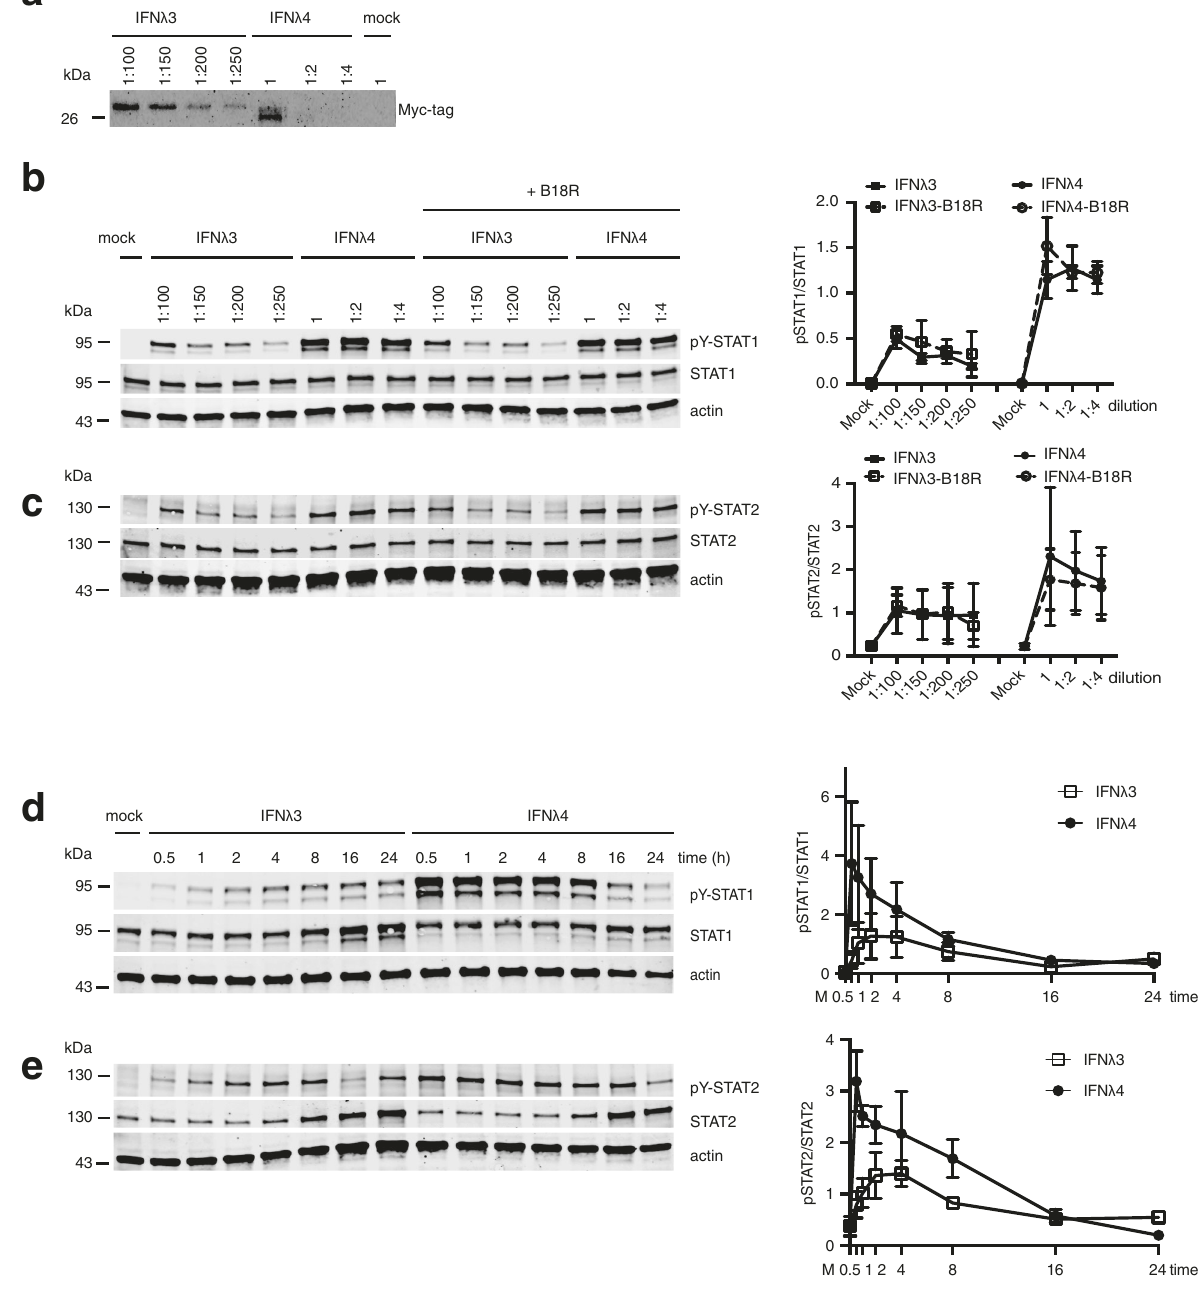
Fig. 2 IFN λ 4 is poorly secreted but very potently activates JAK-STAT signaling. a Huh7 cells were transfected with IFN λ 3-Myc-His and IFN λ 4-Myc-His plasmids or mock vector (mock) and cell-culture supernatants were collected 48 h later. IFN λ 3 and IFN λ 4 containing supernatants were diluted as indicated and 50 µ l each was analyzed by Myc-tag-speci fi c western blotting. Data are representative of n = 3 independent experiments. b , c Huh7-LR cells were seeded in a 48-well plate and pre-treated with B18R (500 ng/ml) for 2 h or left untreated. After washing, cells were stimulated for 30 min with 150 μ l of IFN λ 3 and IFN λ 4 containing supernatants at the same dilutions shown in ( a ). Stimulated cells were lysed and analyzed for STAT activation by western blotting for ( b ) pY – STAT1 and STAT1 and ( c ) pY-STAT2 and STAT2 and actin as a loading control. The western blot signals were quanti fi ed and the ratios of phospho-STAT1/2 to total STAT1/2 were plotted. Results are presented as mean ± SEM of n = 3 independent experiments. Solid line with fi lled squares, IFN λ 3; dashed line with empty squares, IFN λ 3-B18R; solid line with fi lled circles, IFN λ 4; dashed line with empty circles, IFN λ 4-B18R. d , e Huh7-LR cells were stimulated with 150 μ l of 1:100 diluted IFN λ 3 or undiluted IFN λ 4 containing supernatant for the indicated time or were mock-treated. STAT1 ( d ) and STAT2 ( e ) activation was assessed as described in ( b , c ). The western blot signals were quanti fi ed and the ratios of phospho-STAT1/2 to total STAT1/2 were plotted. Results are presented as mean ± SEM of n = 3 independent experiments. Solid line with empty squares, IFN λ 3; solid line with fi lled circles, IFN λ 4. Source data are provided as a Source Data fi le.